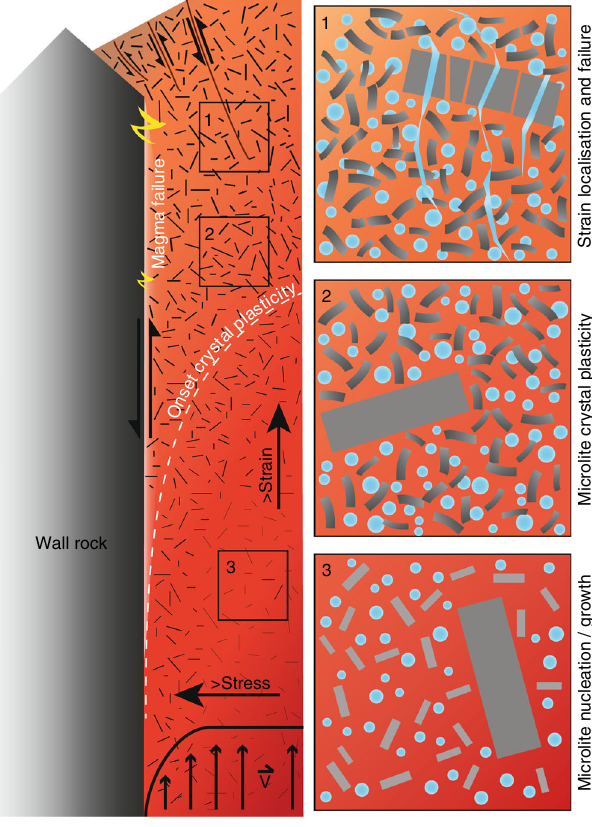
Fig. 7 Deformation mechanisms in the conduit. Schematic of conduit processes and the locus of deformation mechanisms inferred in ascending magma, with panel insets (1 – 3) highlighting these processes at a fi ner scale. This shows the velocity pro fi le active along the length of the conduit ð V and the transition from bulk viscous fl ow during crystallisation in the lower conduit (panel 3), through to strain partitioning that results in crystal plasticity in the microlites (indicated by grey scale variation in panel 2) in the mid-upper conduit and near the margins (where strain localises and shear stress is higher), and fi nally to the onset of brittle deformation with further increasing stress, strain or strain rate as the strength of the crystals and interstitial melt is exceeded and fractures propagate (panel 1) in the upper part of the